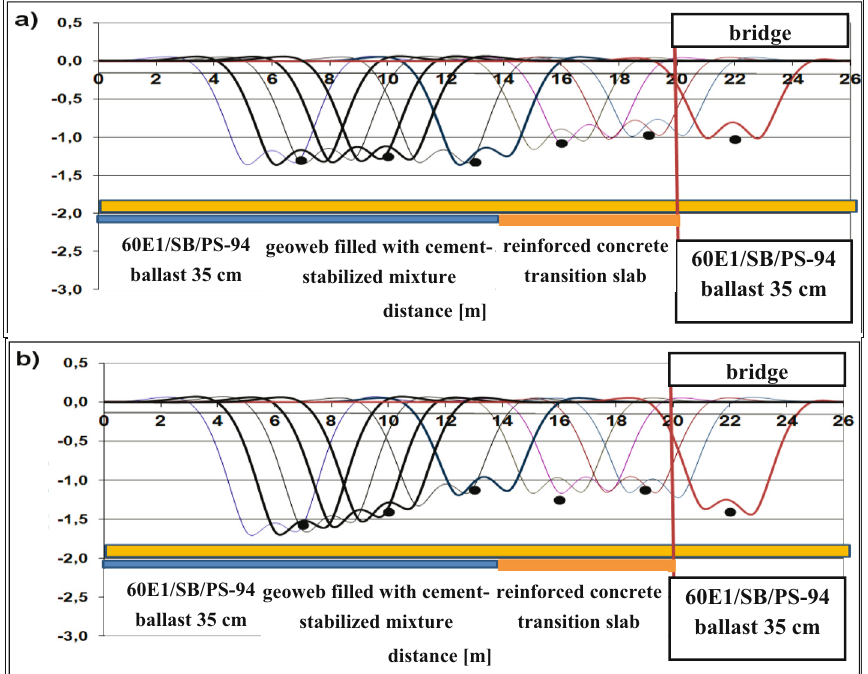
Figure 5: Calculated rail de fl ection lines in the transition zone compared with the measurements of rail de fl ections ( denoted by dots ) : ( a ) north side of the object and ( b ) south side of the object.